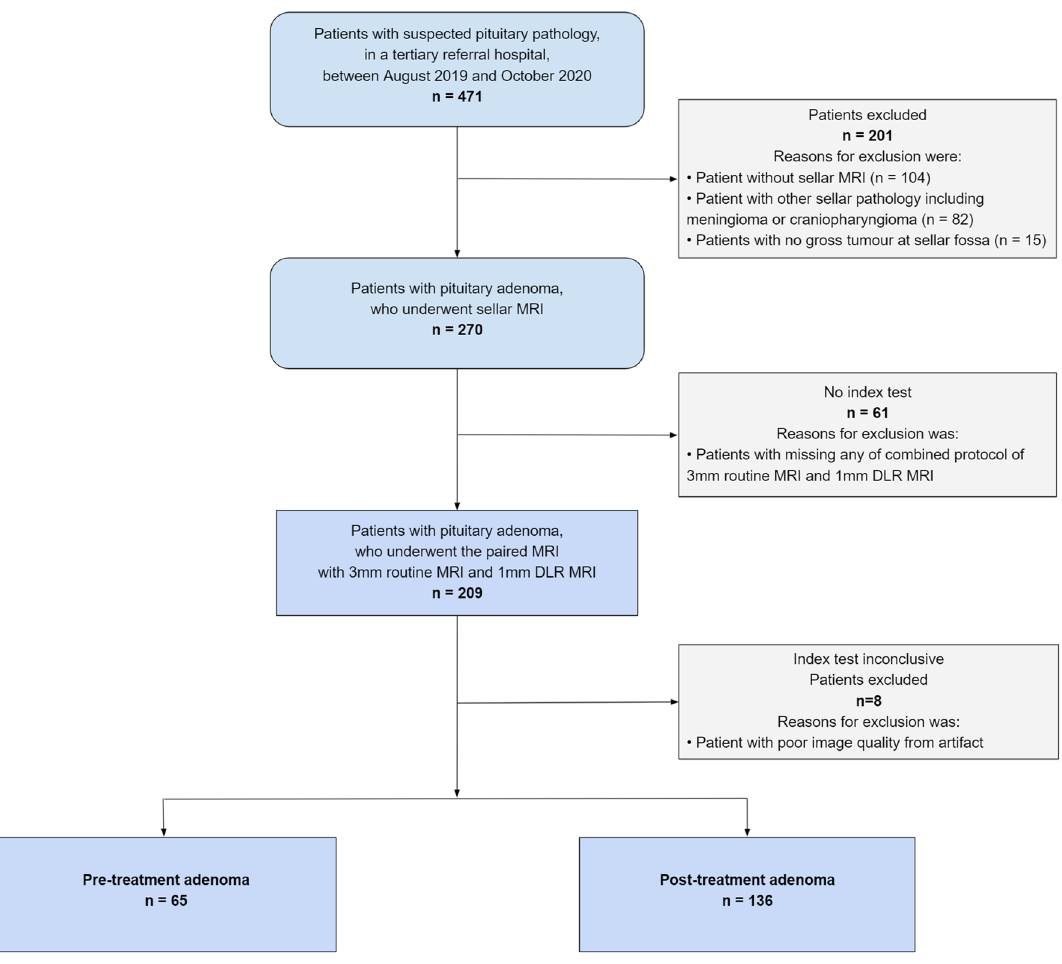
Figure 1. Flow chart of the patients included in the study. MRI magnetic resonance